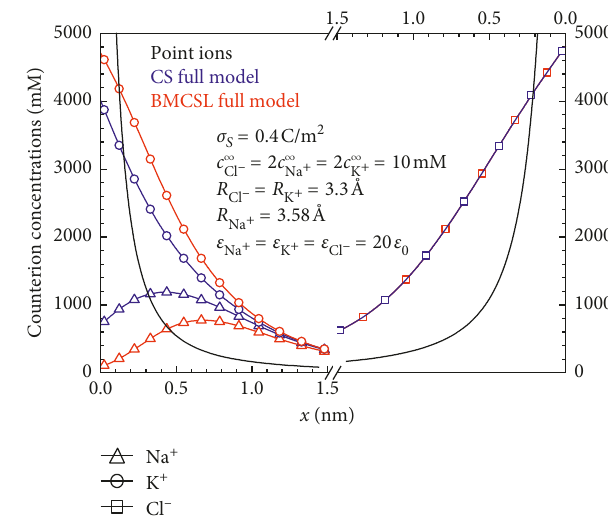
Figure 8: Counterion concentration profiles in the diffuse electric double layers near negative (left) and positive (right) interfaces, calculated for the CS and BMCSL full models and mixed aqueous NaCl and KCl solutions with the indicated parameters.